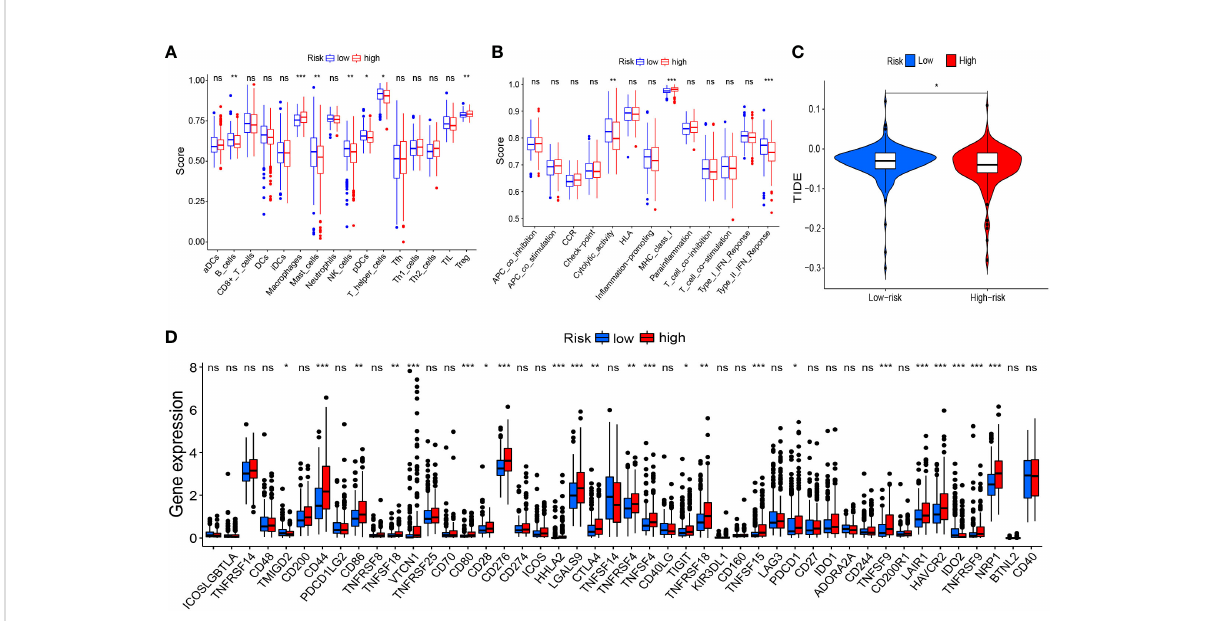
FIGURE 8 Risk signature-related immune landscapes. (A, B) Differences in scores of immune cells and immune function between high- and low-risk groups. (C) TIDE scores of high- and low-risk groups. (D) Differential expression of immune-checkpoint genes between high- and low-risk groups. *P<0.05, **P<0.01, ***P<0.001, ns, not signi fi cant. TIDE, Tumor Immune Dysfunction and